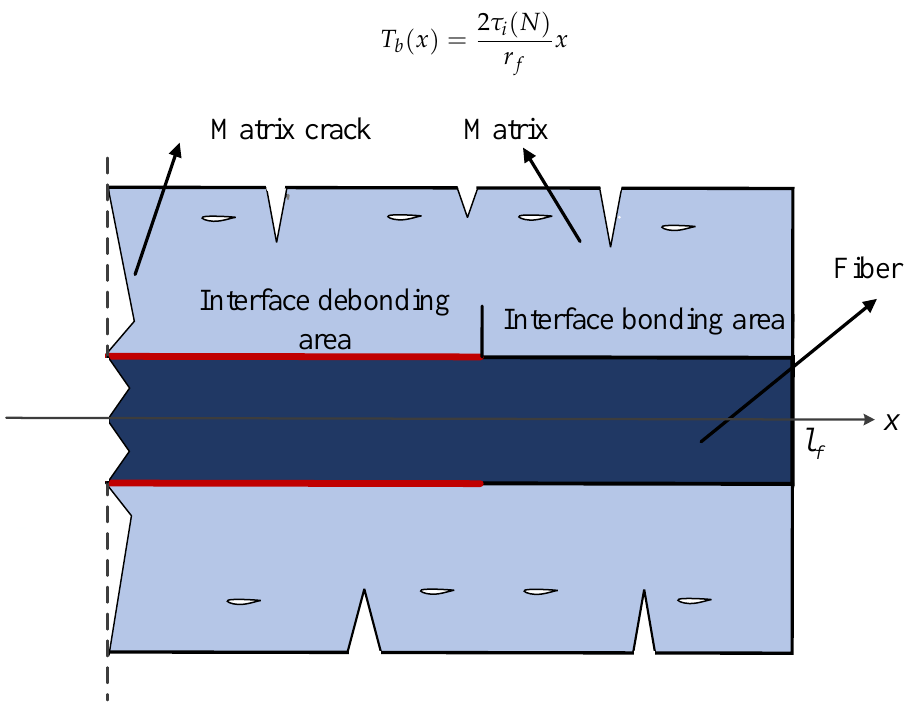
Figure 1. Fiber fracture area. After the fiber is broken, the load it bears will drop instantly. In order to restore the stress borne by the broken fiber to before the break, the broken fiber needs to continue sliding relative to the matrix. Suppose that the slip length required by the stress borne by the broken fiber to restore to its pre-fracture stress is